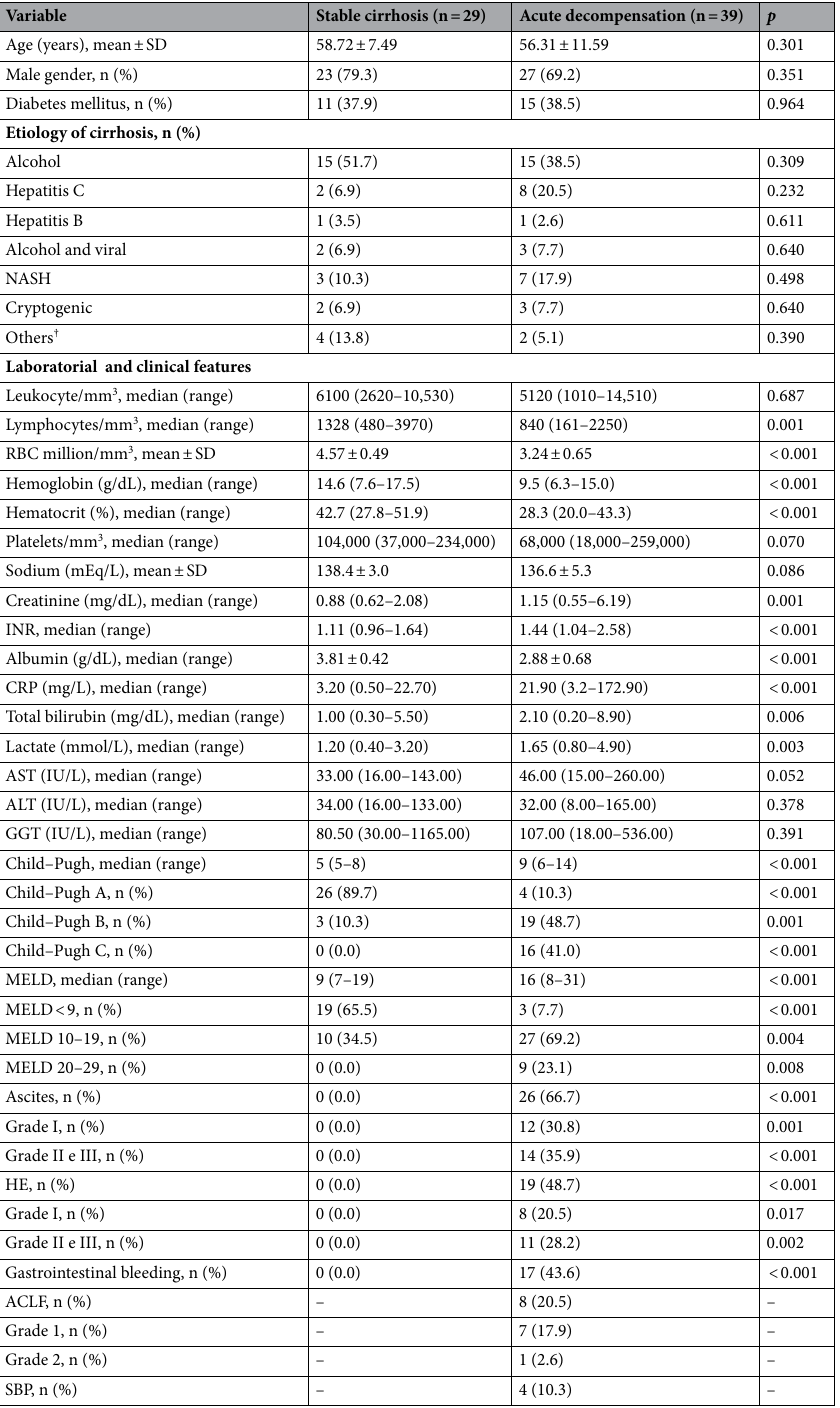
Table 1. Characteristic of the cirrhotic patients. AST Aspartate aminotransferase, ALT Alanine aminotransferase, CRP C-reactive protein, GGT Gamma-glutamyl transferase, HE Hepatic encephalopathy, INR International normalized ratio, MELD Model for end-stage liver disease, RBC Red blood cells, SPB Spontaneous bacterial peritonitis. NASH Nonalcoholic steatohepatitis. † Other etiologic factors included hemochromatosis, Wilson’s disease, and secondary biliary